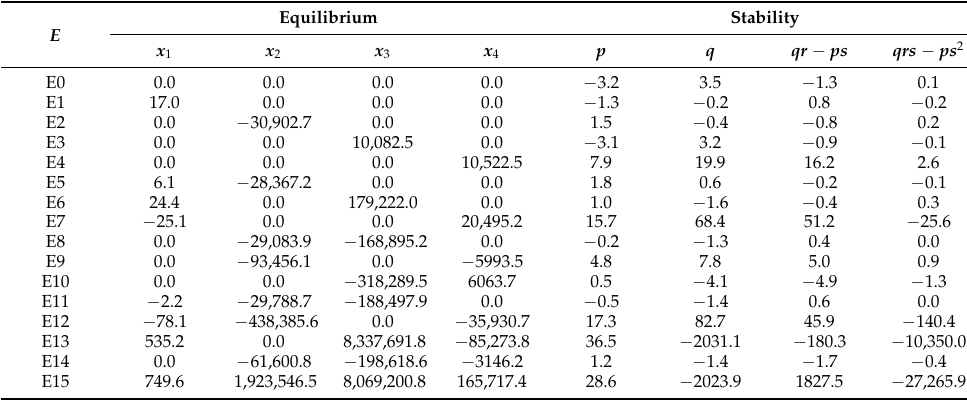
Table 6. Estimated equilibrium and eigenvalues in